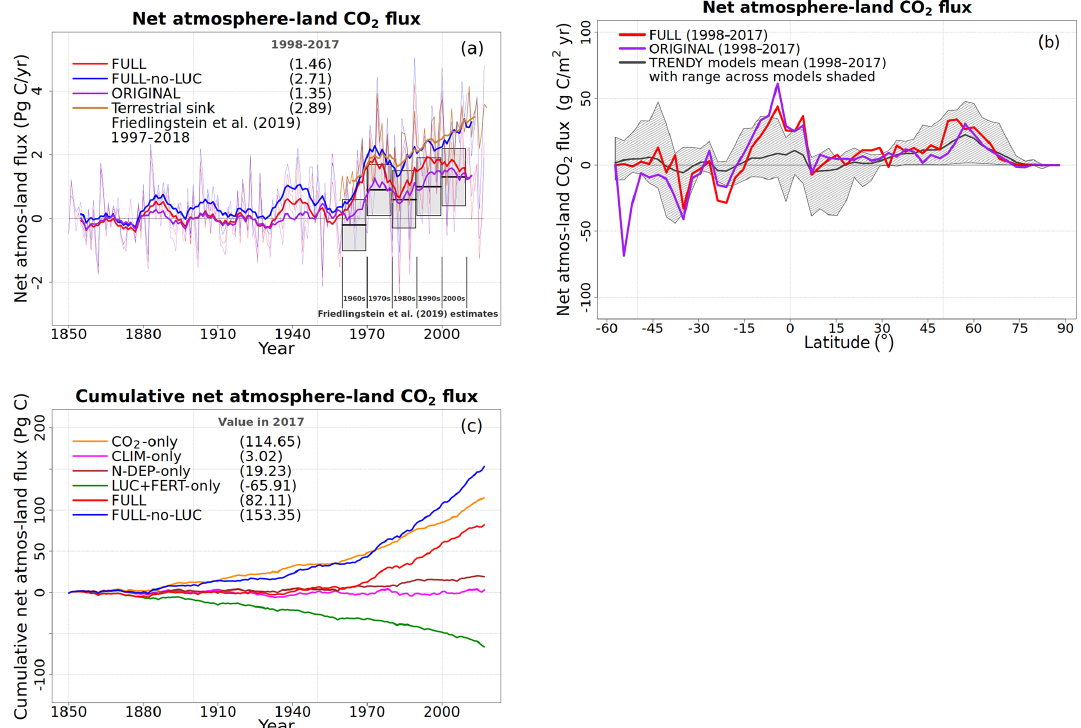
Figure 11. Comparison of simulated net atmosphere–land CO 2 flux from various simulations. (a) Compares globally summed values of net atmosphere–land CO 2 flux from FULL, FULL-no-LUC simulation, and ORIGINAL simulations with estimate of terrestrial sink (dark-yellow line) and net atmosphere–land CO 2 flux (grey bars) from Friedlingstein et al. (2019). The thin lines show the annual values, and the thick lines show their 10-year moving average. (b) Compares zonal distribution of net atmosphere–land CO 2 flux from FULL and ORIGINAL simulations with the range from TRENDY models that contributed to the Friedlingstein et al. (2019) study. (c) Shows cumulative values of net atmosphere–land CO 2 flux from the six primary simulations to investigate the contribution of each forcing to the cumulative land carbon sink over the historical